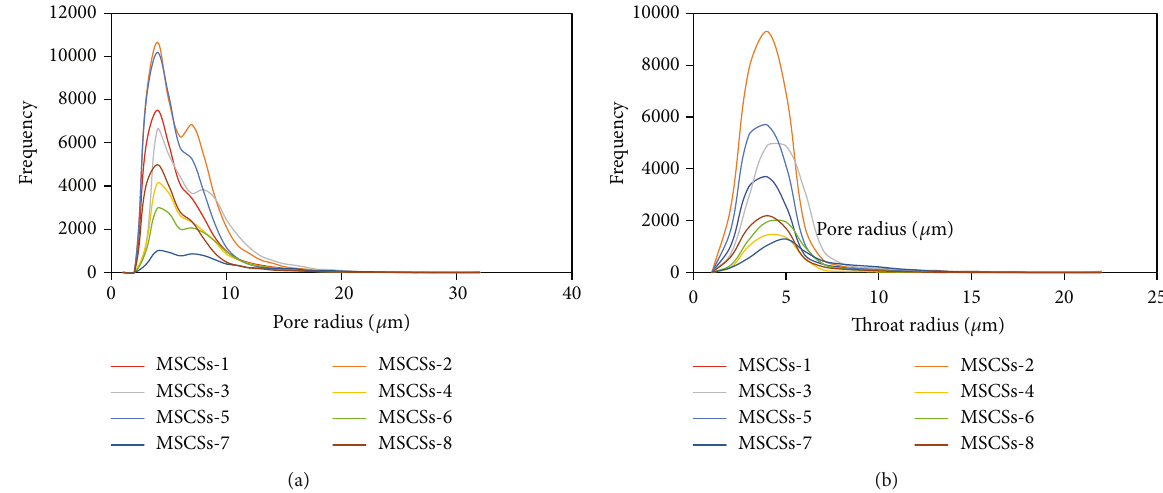
Figure 5: Pore throat size distribution of tight reservoir samples from the upper member of Palaeogene Xiaganchaigou Formation, Qaidam